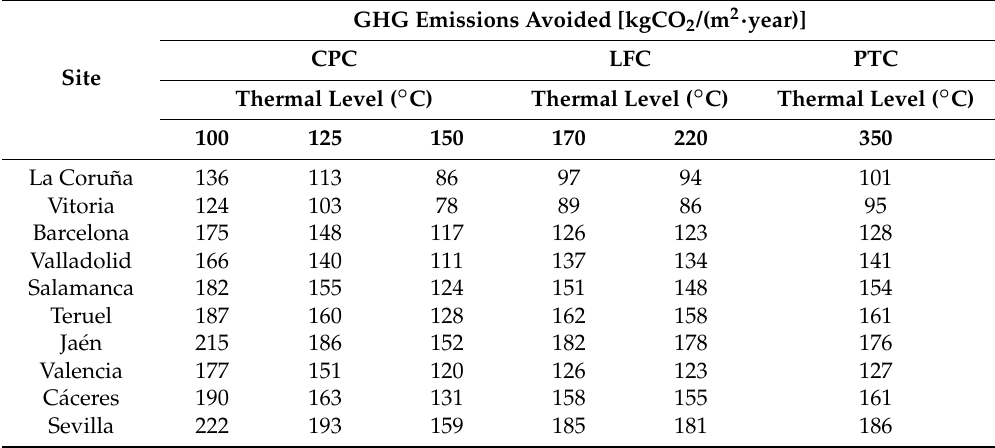
Table 28. GHG emissions annually avoided by the use of solar technologies instead of natural gas.